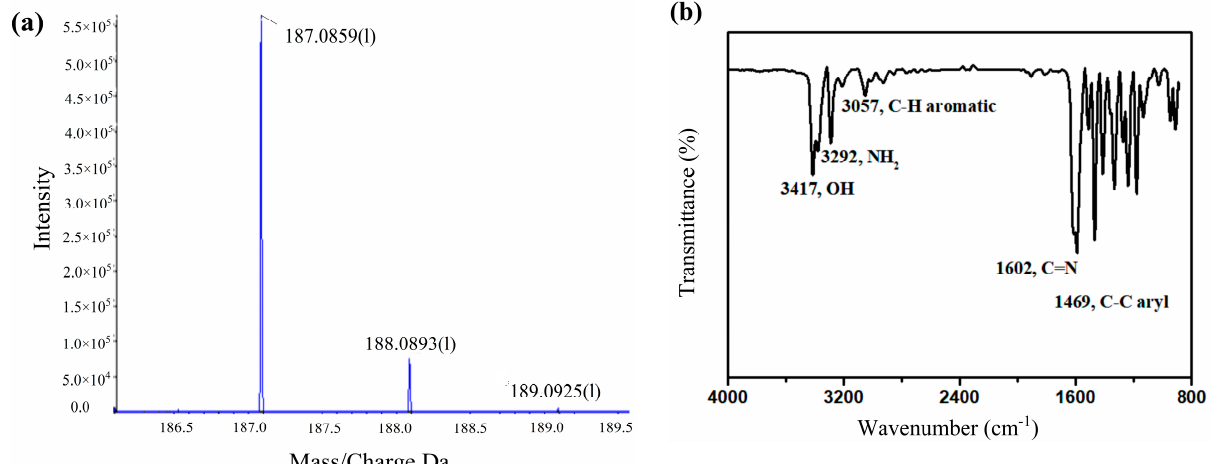
Figure 1. Mass spectrometry ( a ) and infrared spectroscopy ( b ) of the fluorescent probe F6.